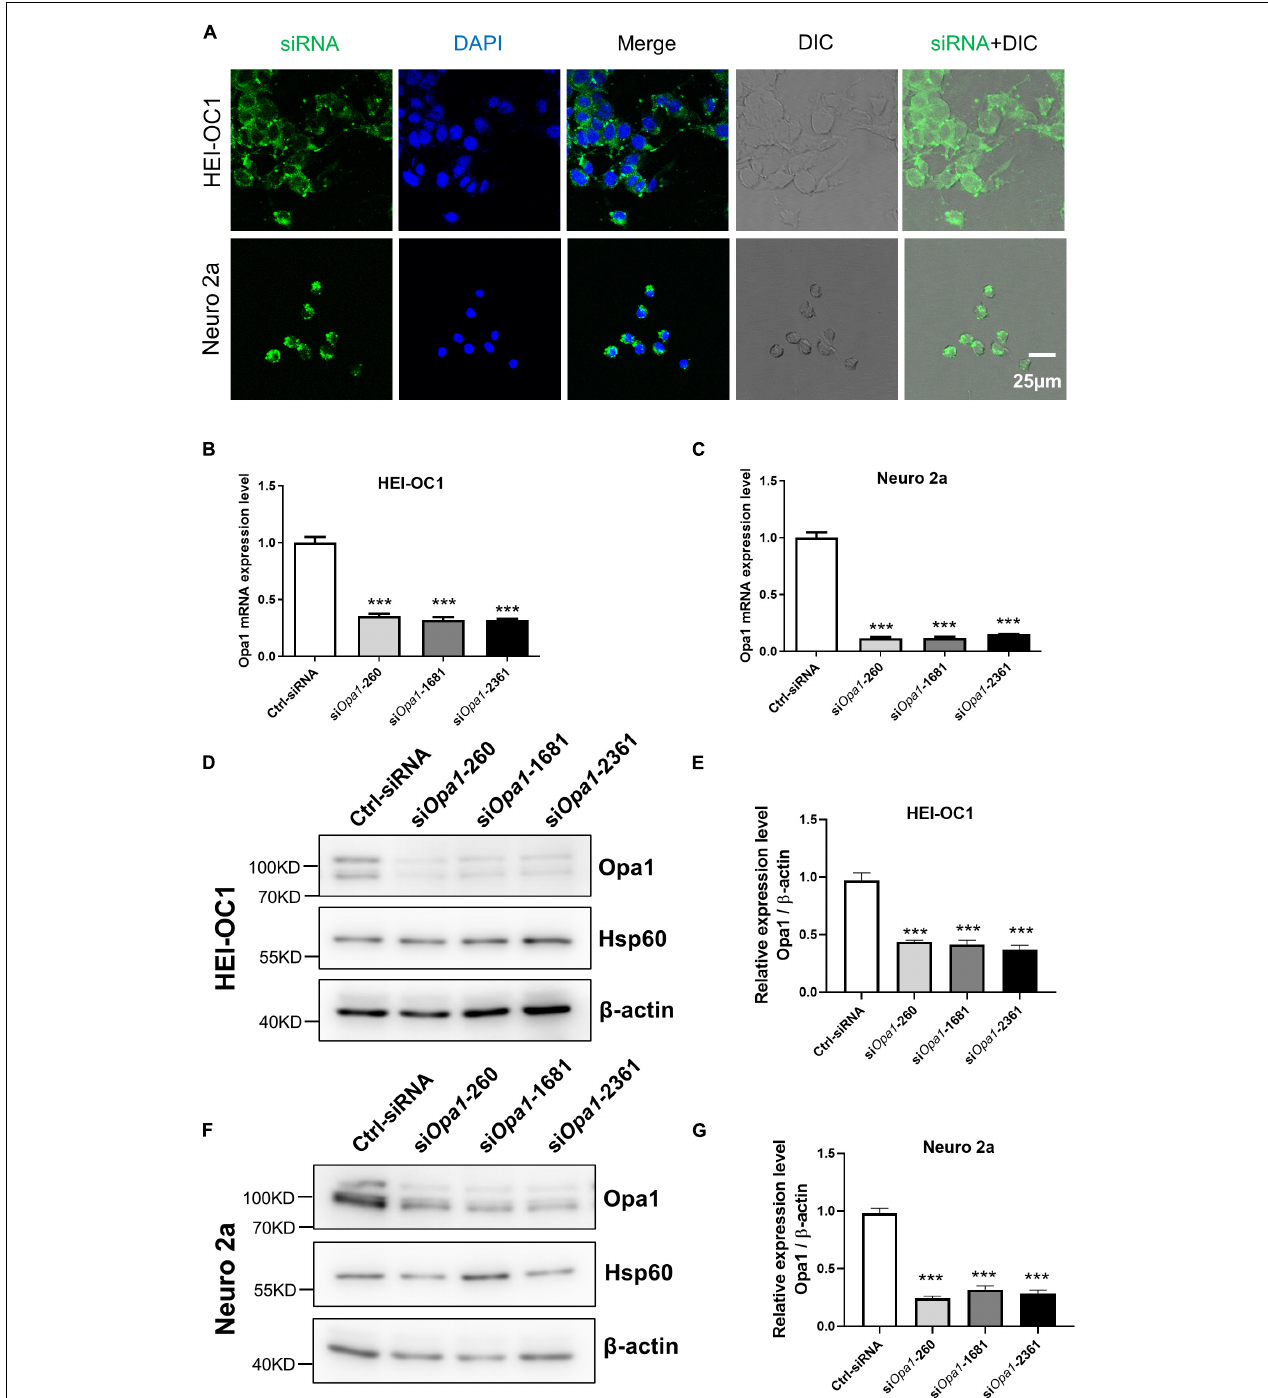
FIGURE 1 | Depletion of Opa1 in HEI-OC1 and Neuro 2a cells. (A) Representative confocal images of HEI-OC1 and Neuro 2a cells after siRNA transfection for 24 h, showing transfection efficiency. DIC: Differential interference contrast. Quantification of Opa1 mRNA expression levels in HEI-OC1 (B) and Neuro 2a (C) cells transfected with si Opa1 for 24 h. In this and all following graphs: the levels of Opa1 mRNA were normalized to that of mouse rpl19; error bars represent standard error of the mean (SEM); and experiments were performed in triplicate and repeated three times. *** p < 0.001 (one-way ANOVA with Dunnett’s multiple comparisons test). Representative Western blot images (D) and quantification (E) of Opa1 expression in HEI-OC1 cells transfected with si Opa1 for 48 h. In this and all following graphs, the protein levels of Opa1 are normalized to that of β -actin. *** p < 0.001 (one-way ANOVA with Dunnett’s multiple comparisons test). Representative Western blot images (F) and quantification (G) of Opa1 expression in Neuro 2a cells transfected with si Opa1 for 48 h. *** p < 0.001 (one-way ANOVA with Dunnett’s multiple comparisons test).